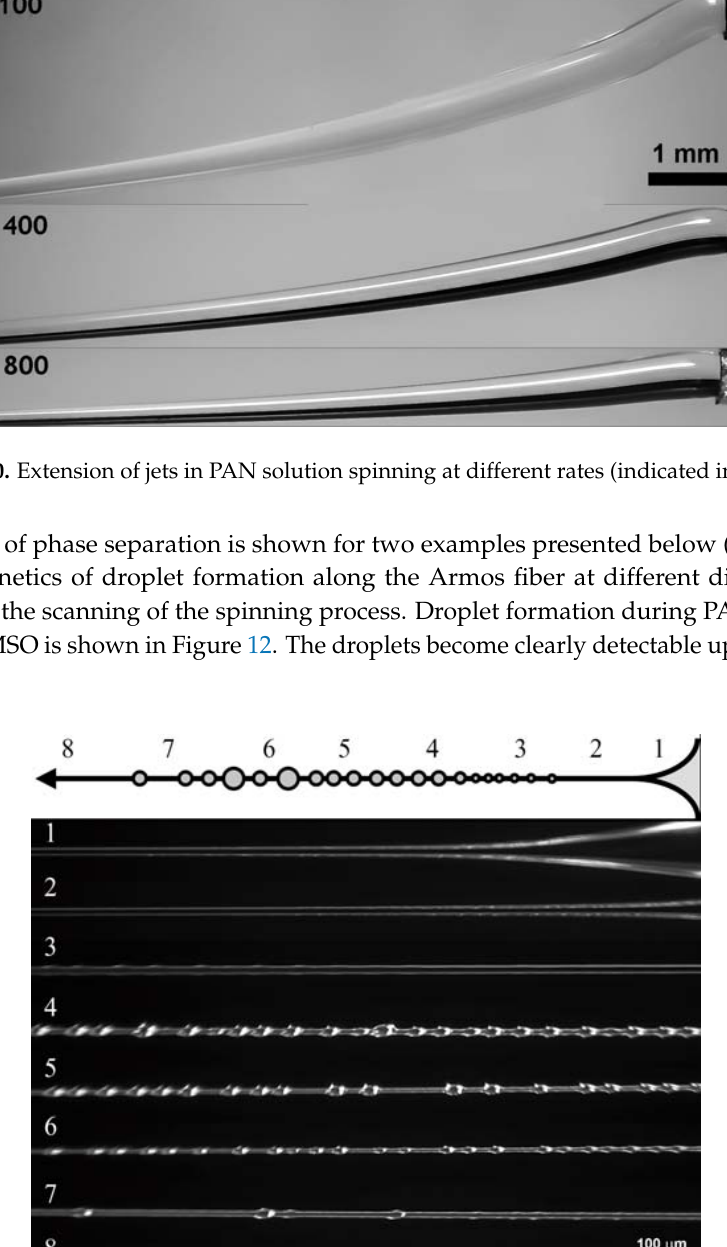
Figure 11. Continuous spinning of fibers from 7% solution of CPABI. Frames correspond to different distance from the spinneret.